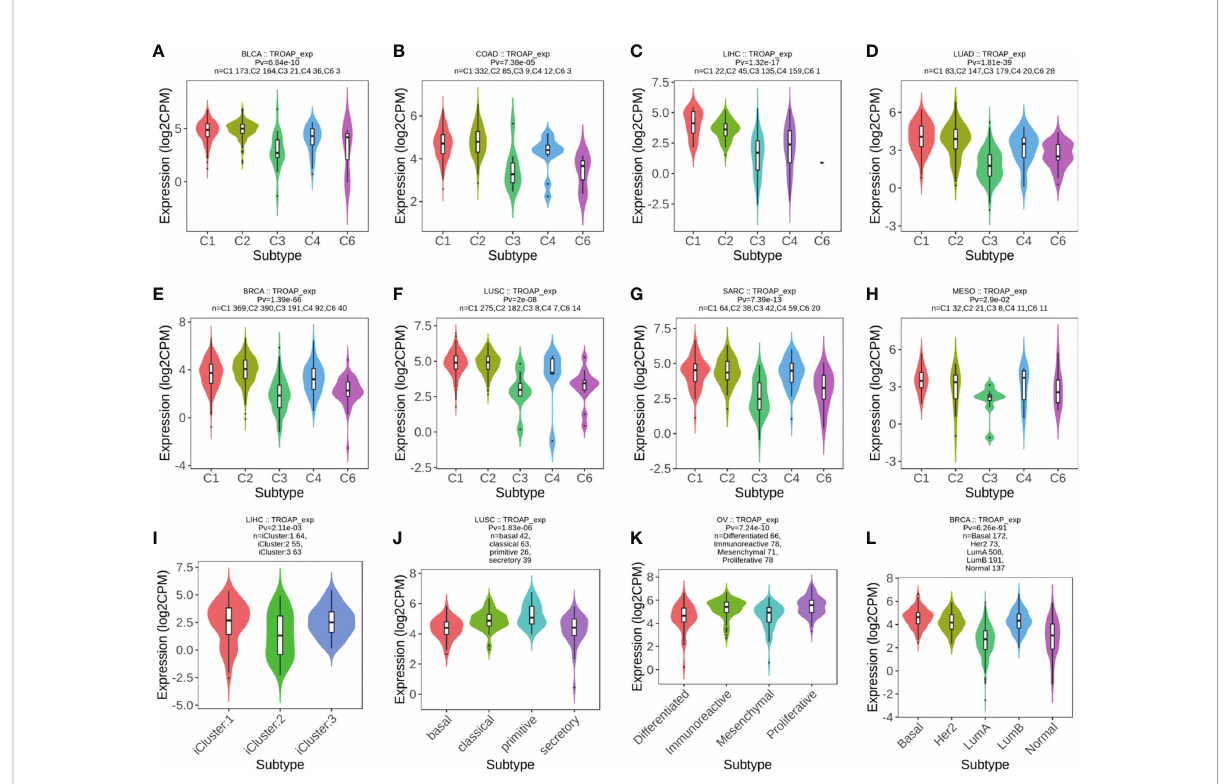
FIGURE 9 (A – H) The correlation of TROAP transcriptional expression and immune subtypes in (A) bladder urothelial carcinoma (BLCA), (B) COAD, (C) LIHC, (D) lung adenocarcinoma (LUAD), (E) BRCA, (F) lung squamous cell carcinoma (LUSC), (G) sarcoma (SARC), and (H) mesothelioma (MESO). (I – L) The relationship between TROAP transcriptional expression and molecular subtypes in (I) LIHC, (J) LUSC, (K) ovarian serous cystadenocarcinoma (OV), and (L) BRCA. C1 (wound healing); C2 (IFN-gamma dominant); C3 (in fl ammatory); C4 (lymphocyte depleted);